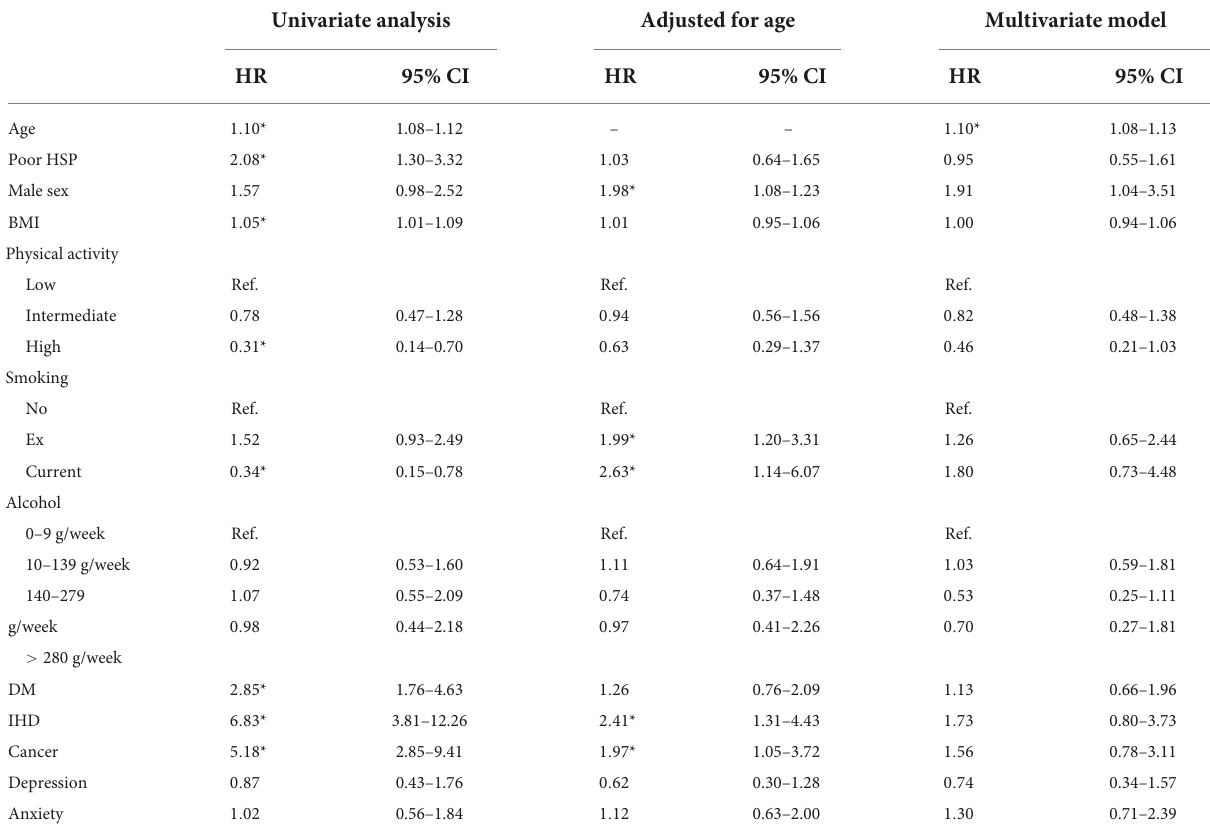
TABLE 4 Univariate and adjusted hazard ratios for exitus and their 95% confidence